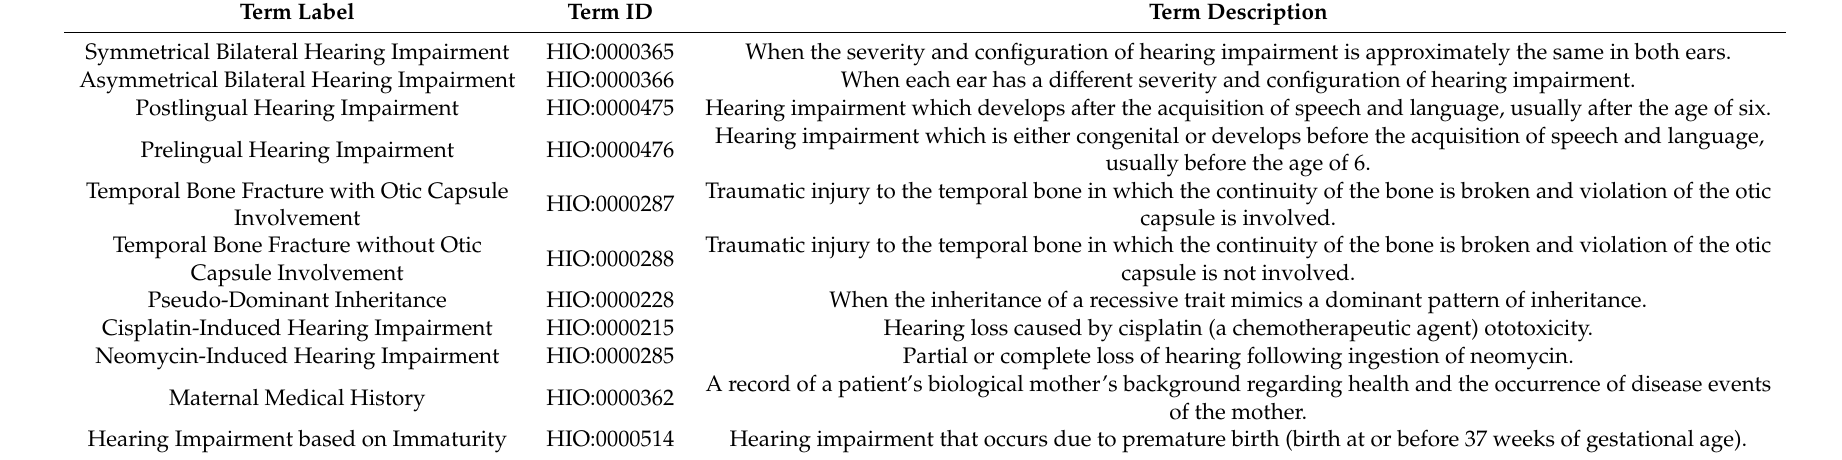
Table 2. Some of terms that are unique to